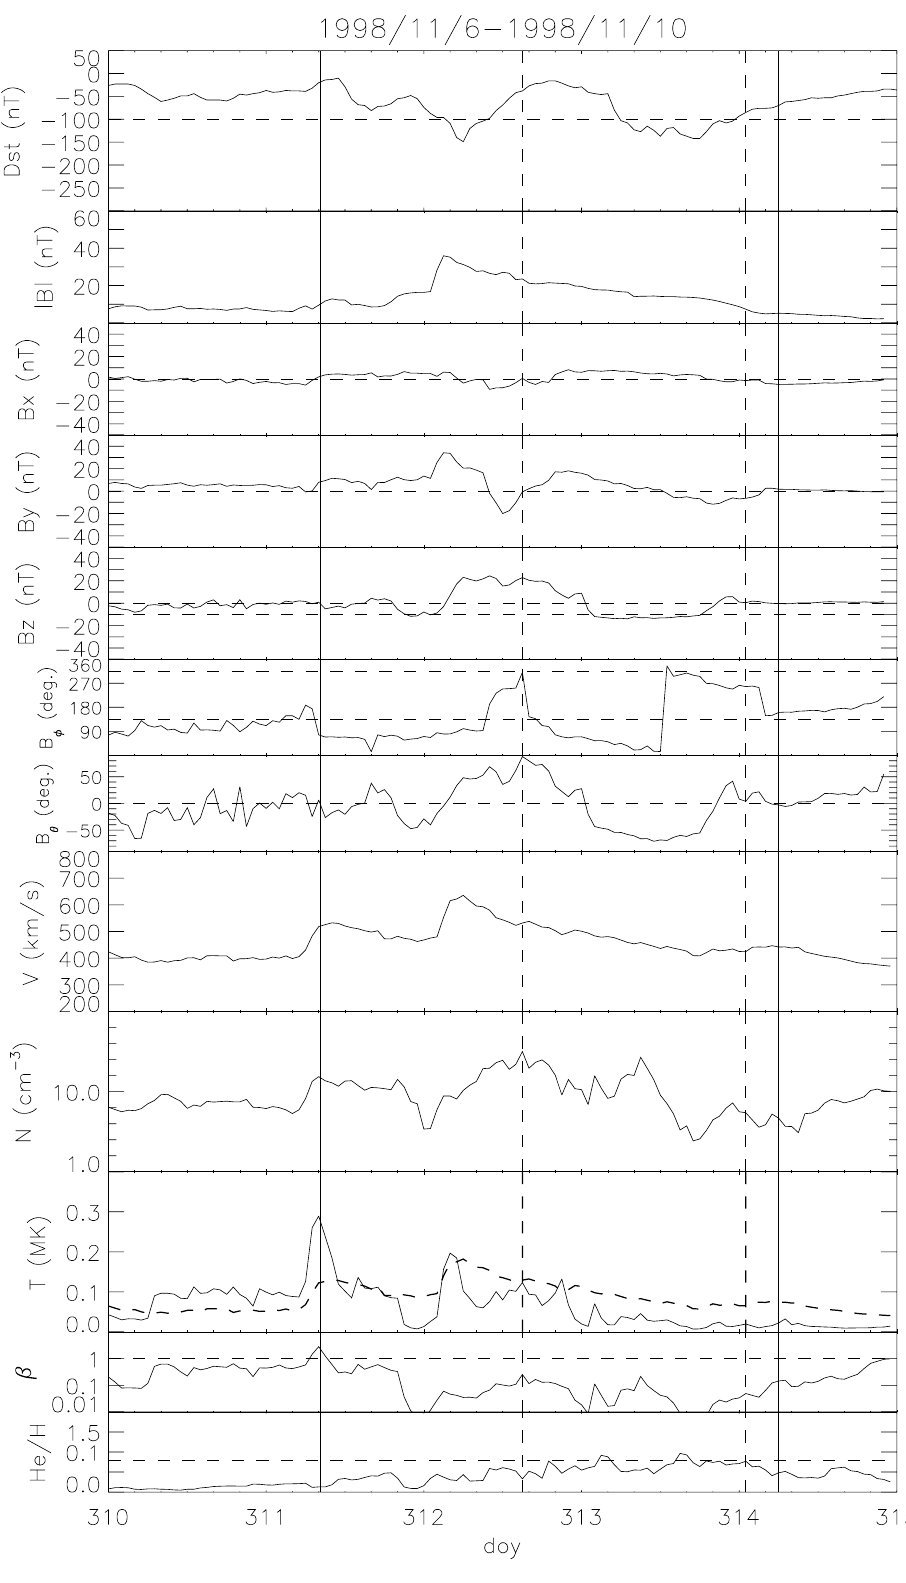
Fig. 7. D st index and solar wind parameters of storm no. 9. Two vertical solid lines show the duration of the geomagnetic storm and two vertical dash lines show the duration of a magnetic flux